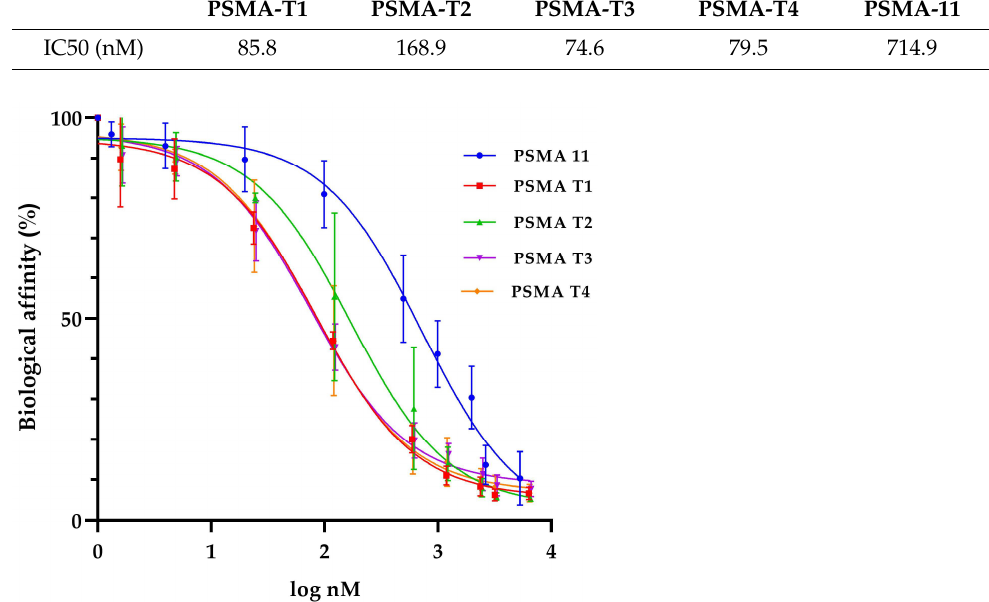
Figure 4. Binding affinity for tested PSMA derivatives on LNCaP prostate cell membranes and [ 131 I]I-MIP1095 as a competitive radioligand. Table 5. IC50 values for tested PSMA derivatives on LNCaP prostate cell membranes and [ 131 I]I- MIP1095 as a competitive radioligand.